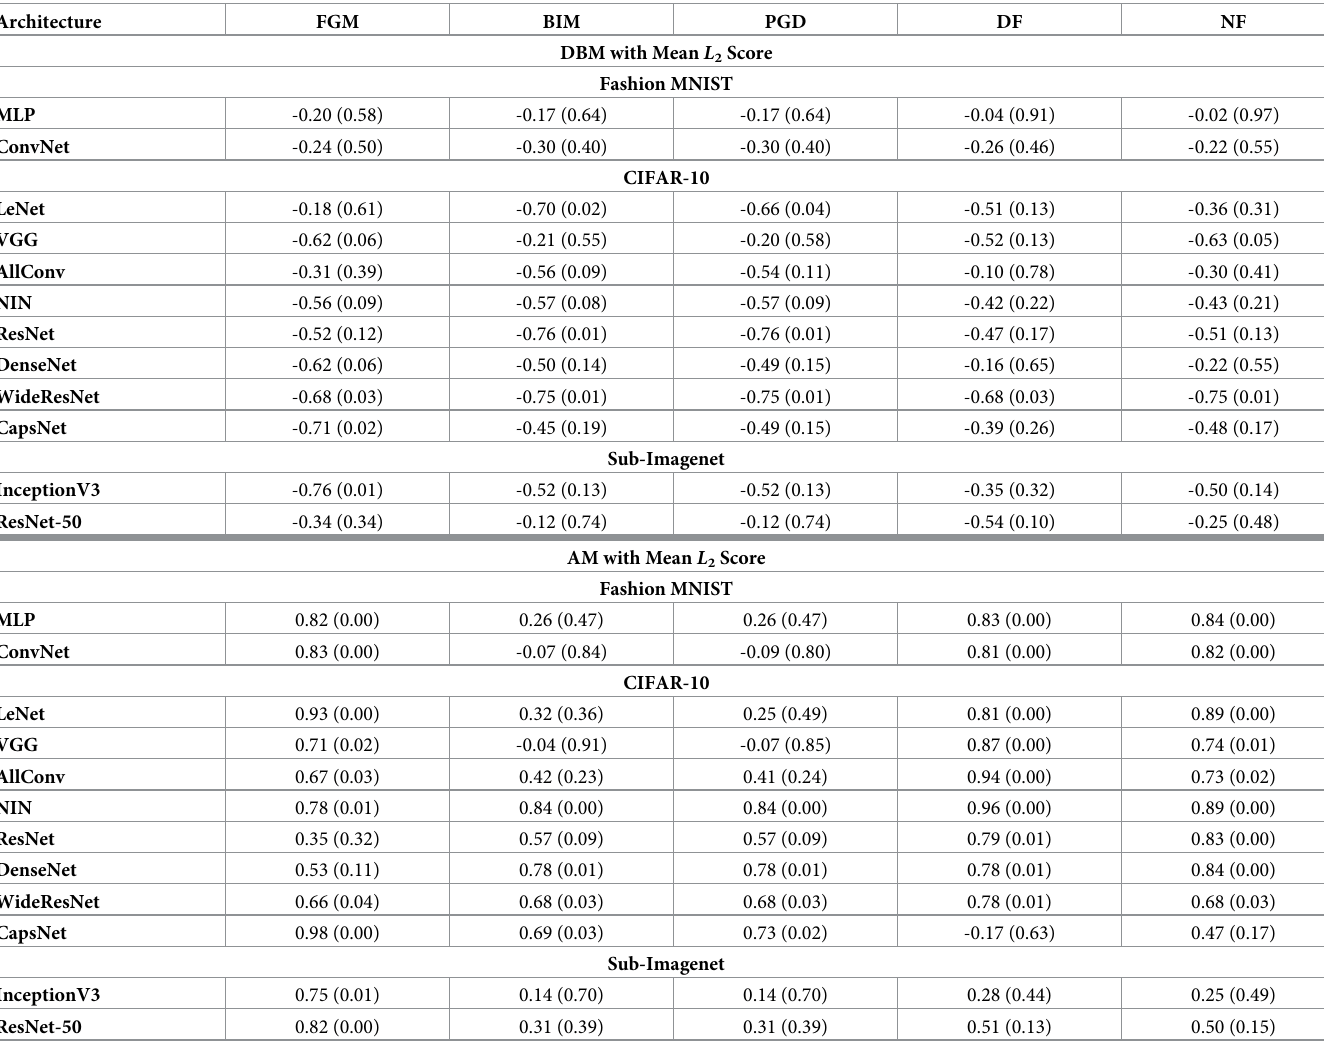
Table 3. Pearson correlation coefficient values of Davies–Bouldin Metric (DBM) and Amalgam Metric (AM) with Mean L 2 Score of adversarial attacks for each vanilla classifier and attack pair.